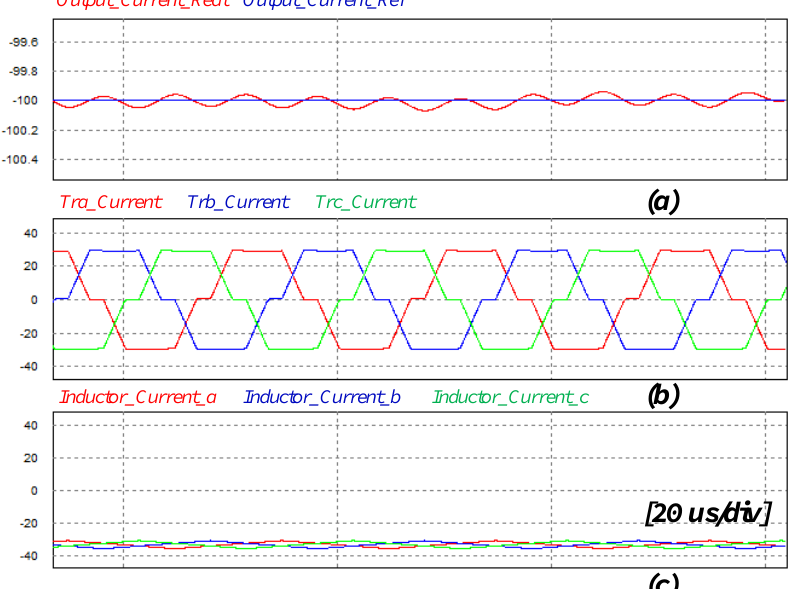
Figure 16. Simulation results of discharging operation ( a ) real output current and reference output current, ( b ) three phase transformer current of the secondary side, and ( c ) three phase inductor current.